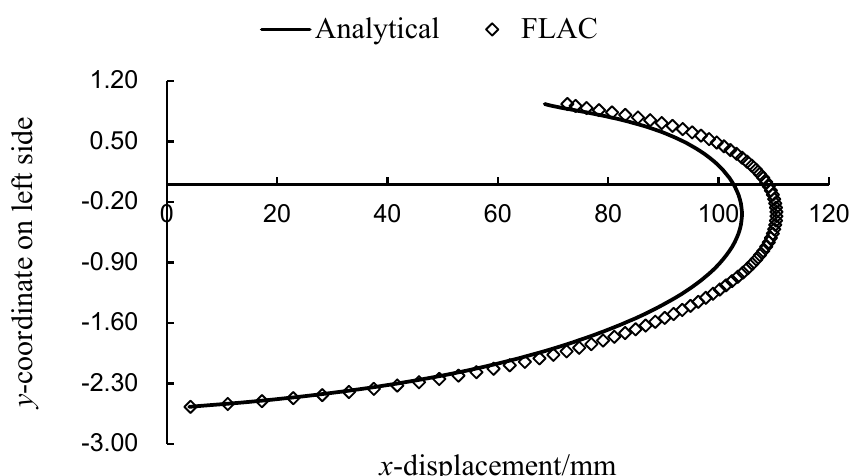
Figure 7. The x -displacement on the left side for right-angle trapezoidal opening.